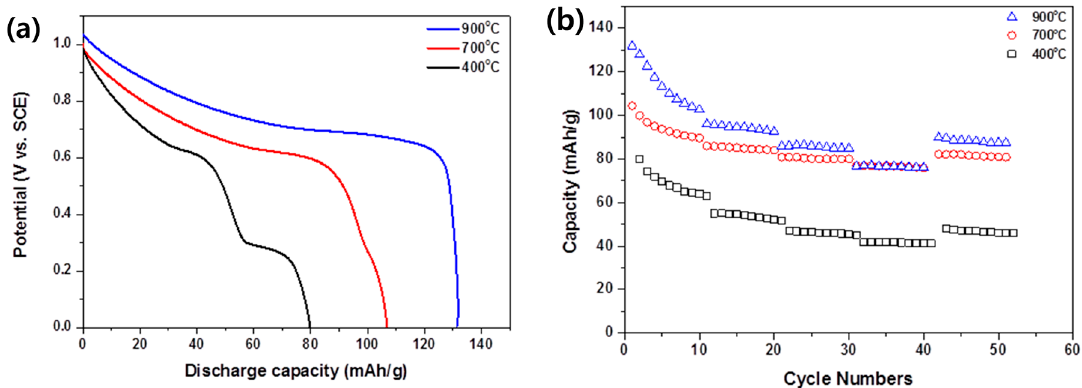
Figure 9. Half-cell test results for ( a ) discharge capacity and ( b ) rate capability.